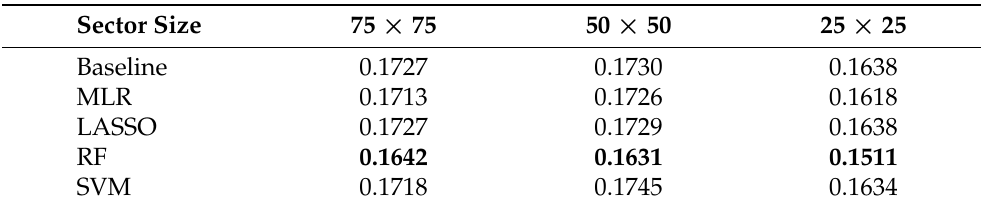
Table 2. RMSE for the different methods. The values in boldface refers to the method that performed the